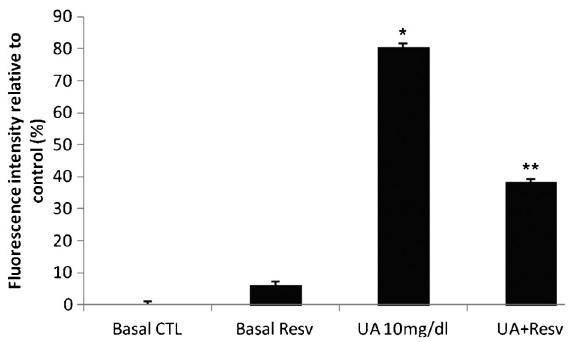
Figure 1. Intracellular calcium concentration in immortalized human mesangial cells (ihMCs) treated with uric acid (UA) and resveratrol (Resv). Briefly, semi-confluent ihMC cells were detached with trypsin and the fluorescence intensity of intracel- lular calcium was determined by Fluo-4/AM in the presence of 10 mg/dL UA and 12.5 m M Resv. Data are reported as the mean percentage (±SE). *P , 0.001 vs control (CTL); **P , 0.005 vs UA (Student t